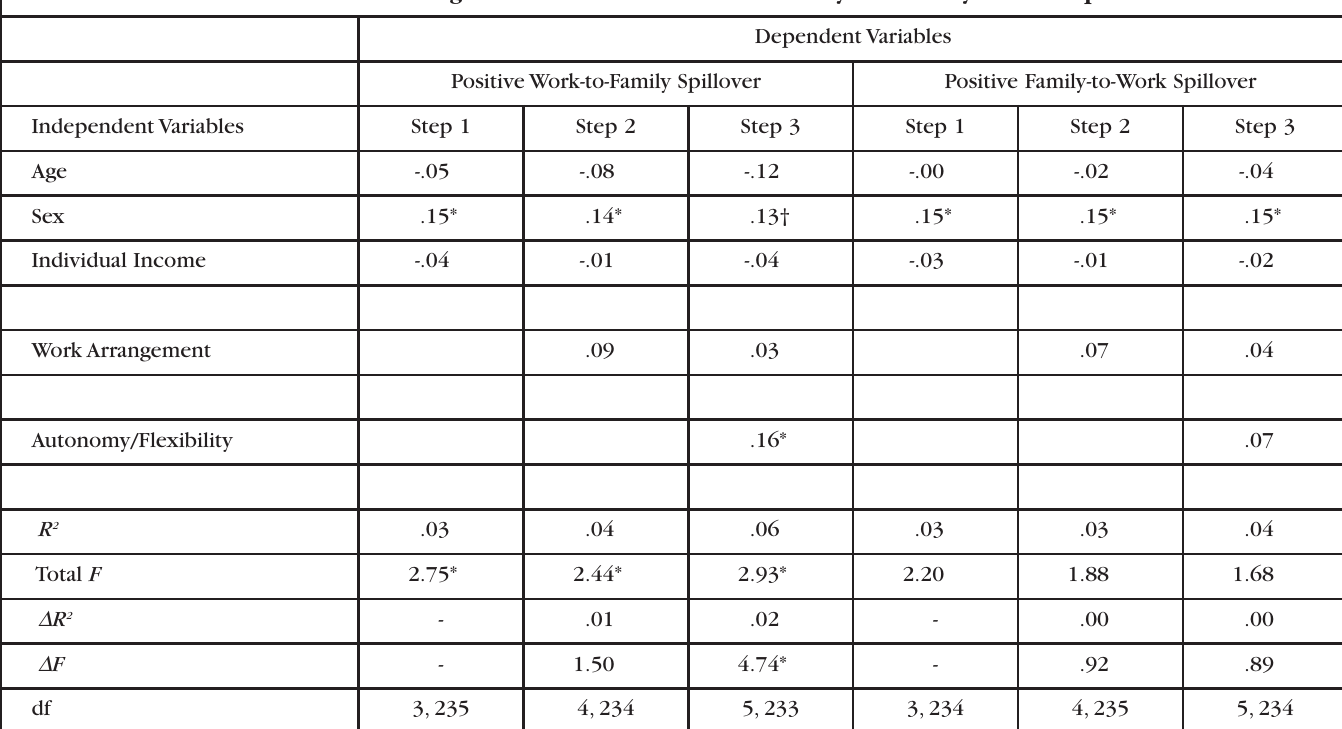
Table 2b. Hierarchical Regressions on Positive Work-to-Family and Family-to-Work